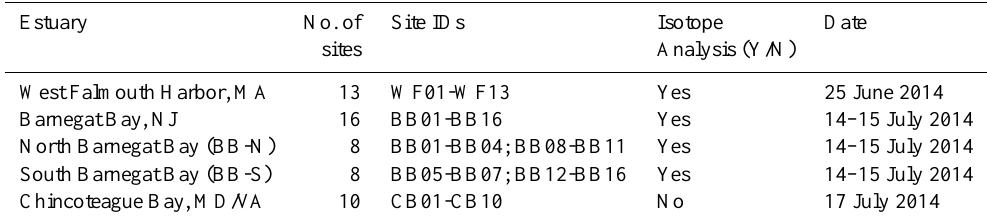
Table 1. Sampling sites and procedures. Estuary No. of Site IDs Isotope sites West Falmouth Harbor, MA Barnegat Bay,